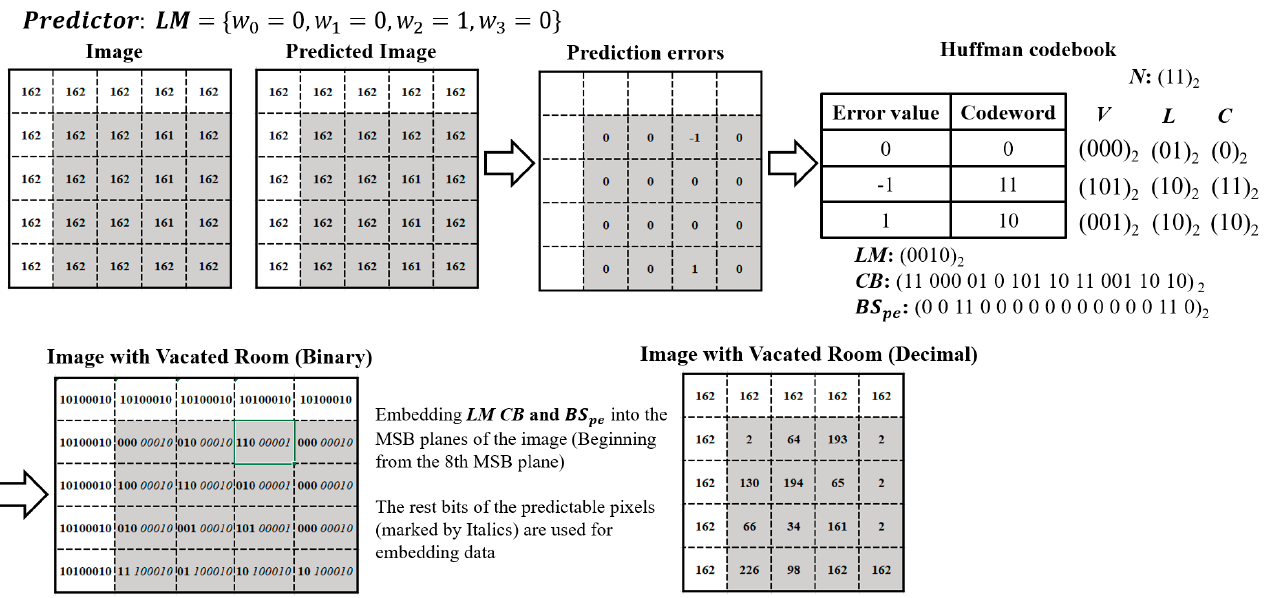
Figure 6. Example of the proposed method.